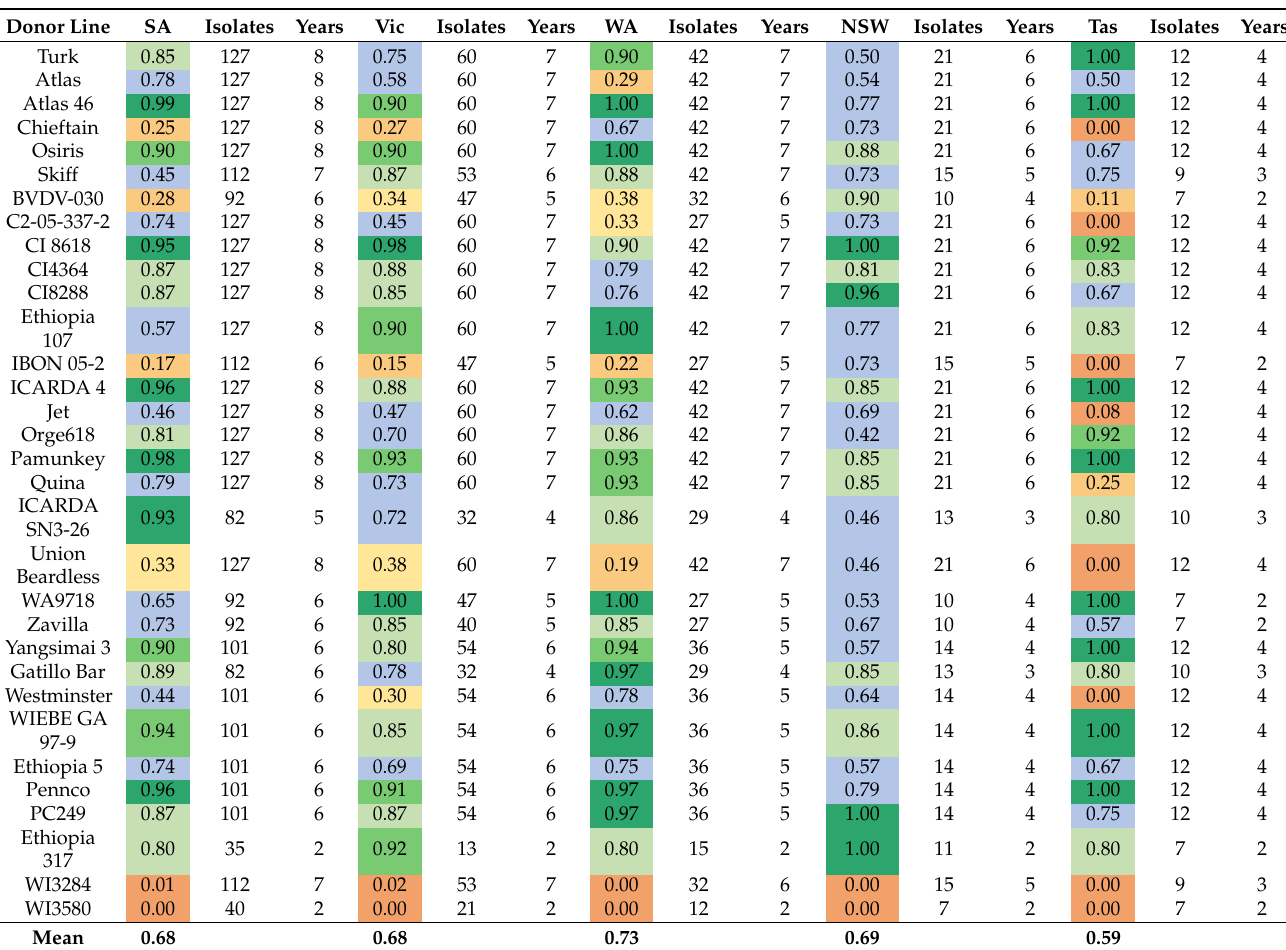
Table 2. Fraction of reactions rated resistant to scald isolates collected in different states between the years 2014–2021. The resistance for each donor includes data in 2020 and 2021 from the derived donor as shown in this table.